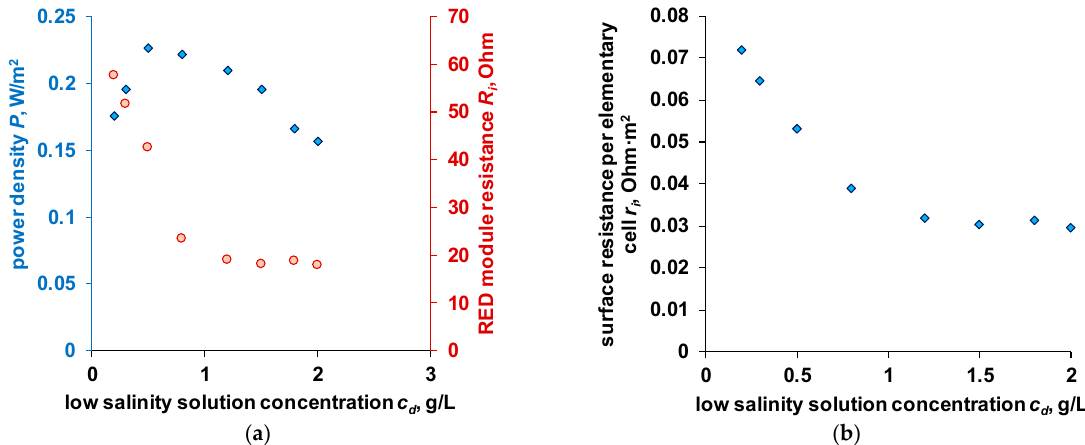
It is known that the maximum power can be obtained when the resistance of the ex-